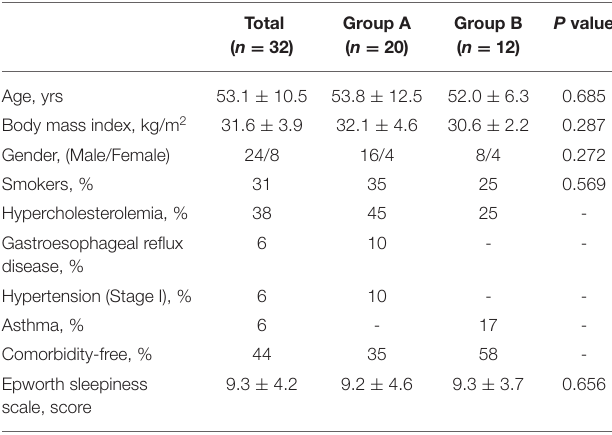
awakening phase ( p = 0.003), REM stage ( p = 0.003), and non- TABLE 1 | Patient